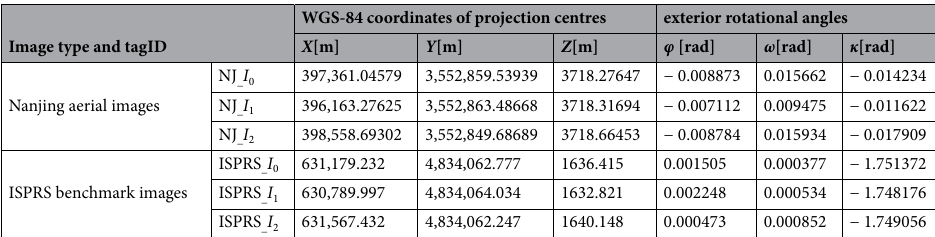
Table 2. Exterior orientation parameters of experimental aerial